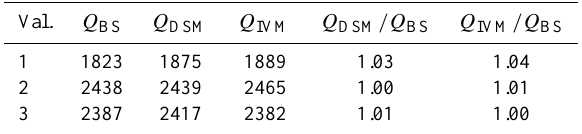
Table 1. Evaluation of channel conditions at Melak station to esti- mate the Manning coefficient.